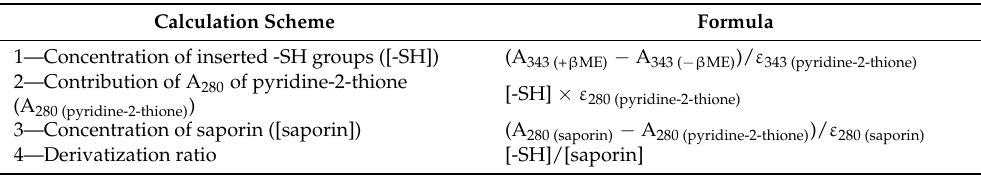
Table 2. Determination of the number of thiol groups (-SH) introduced per protein molecule of saporin derivatized with SPDP or